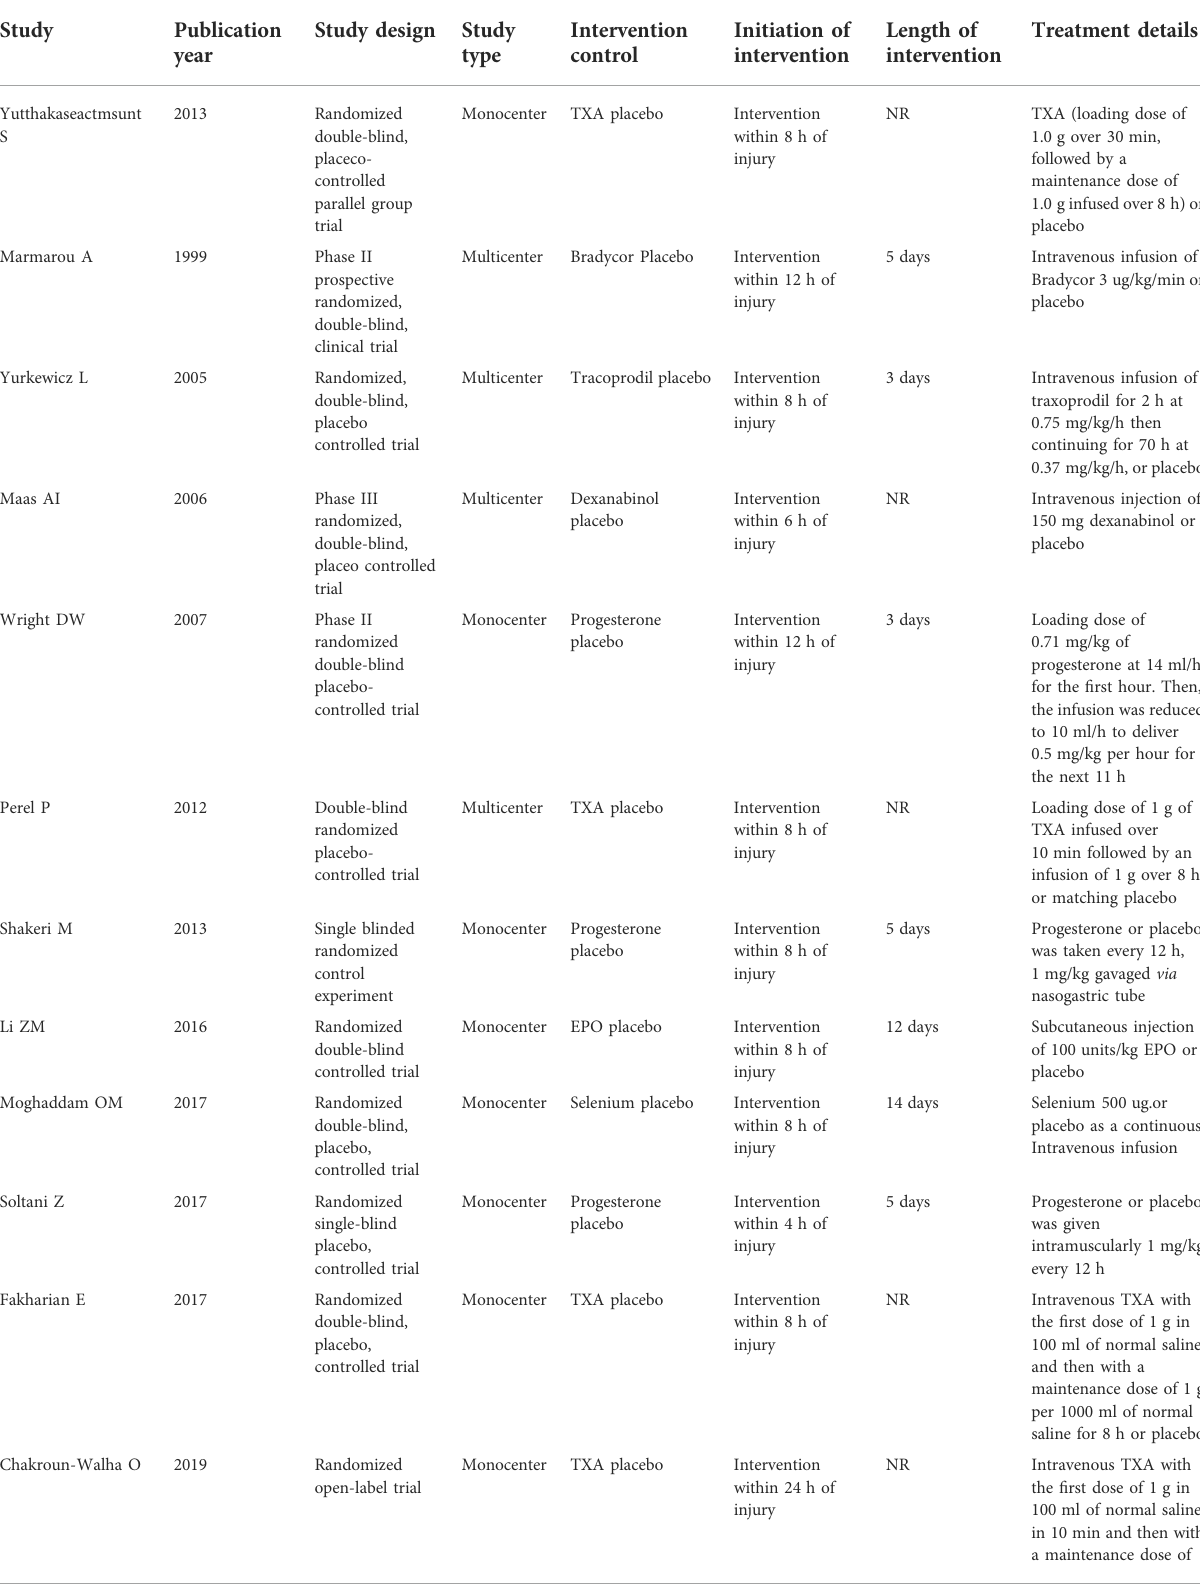
TABLE 2 Overview of the included